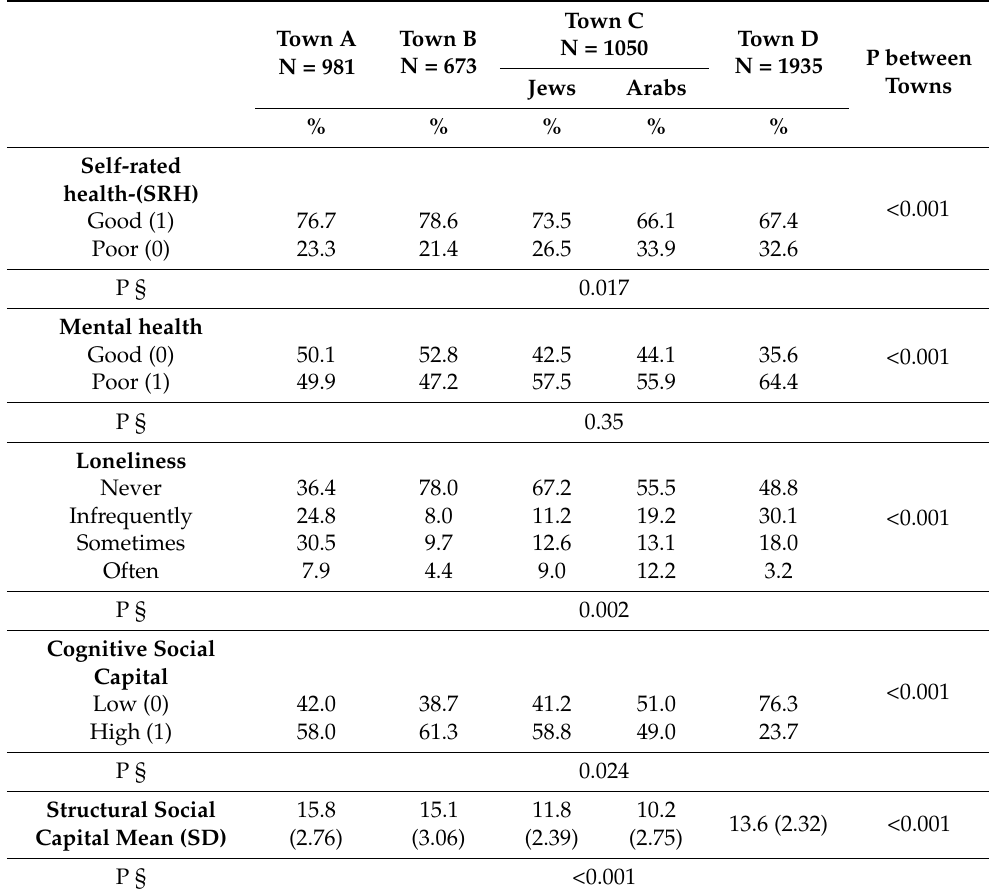
Table 2. Distribution of Self Rated Health (SRH), mental health, loneliness and social capital variables in each town, mean, standard deviation (SD) or percent and